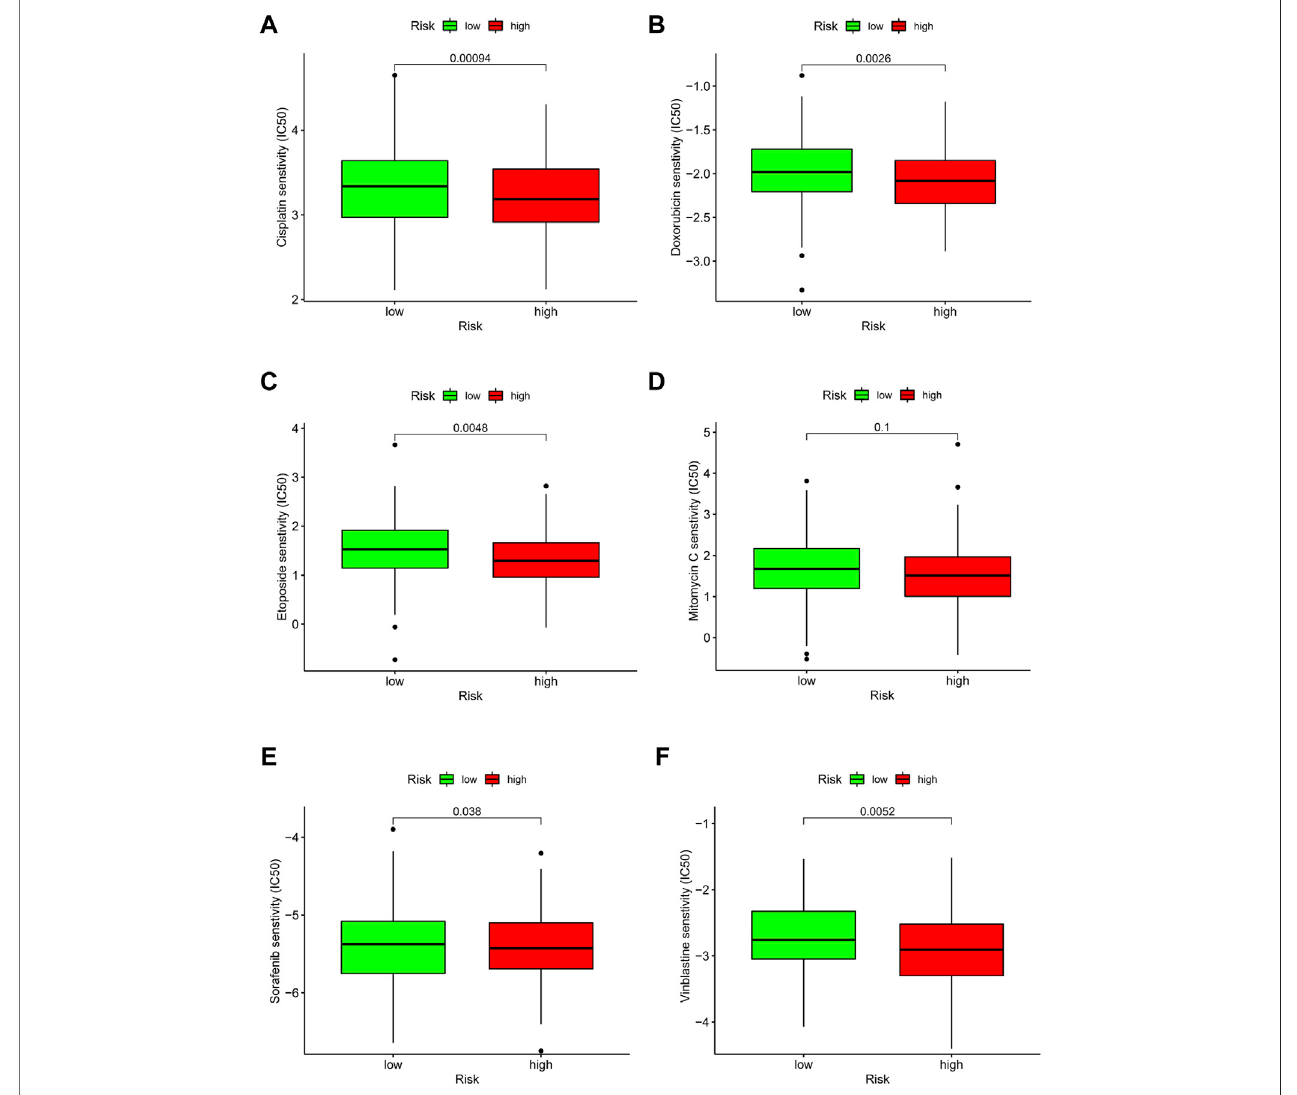
FIGURE11| Drugeffectivenessofdifferentriskgroups. (A) Cisplatin. (B) Doxorubicin. (C) Etoposide. (D) MitomycinC. (E) Sorafenib. (F) Vinblastine.Fiveofthesix drugs showed IC 50 differences ( p < 0.05).